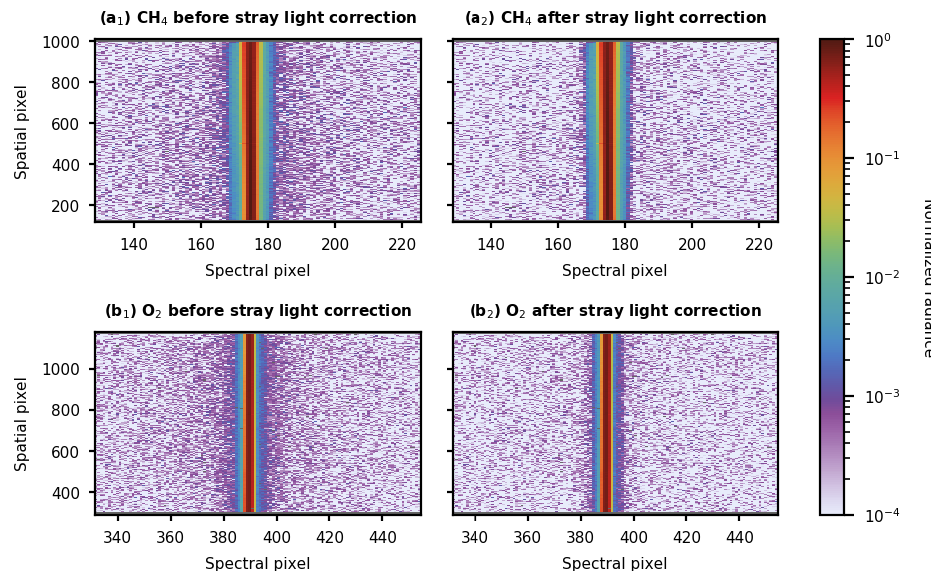
Figure 7. Slit images on the FPA, as given by normalized radiance before (a1, b1) and after (a2, b2) applying stray-light correction. After correction, the slit image at each row (i.e., spectral pixels at a given spatial pixel) is effectively an ISSF as discussed in Sect. 5.